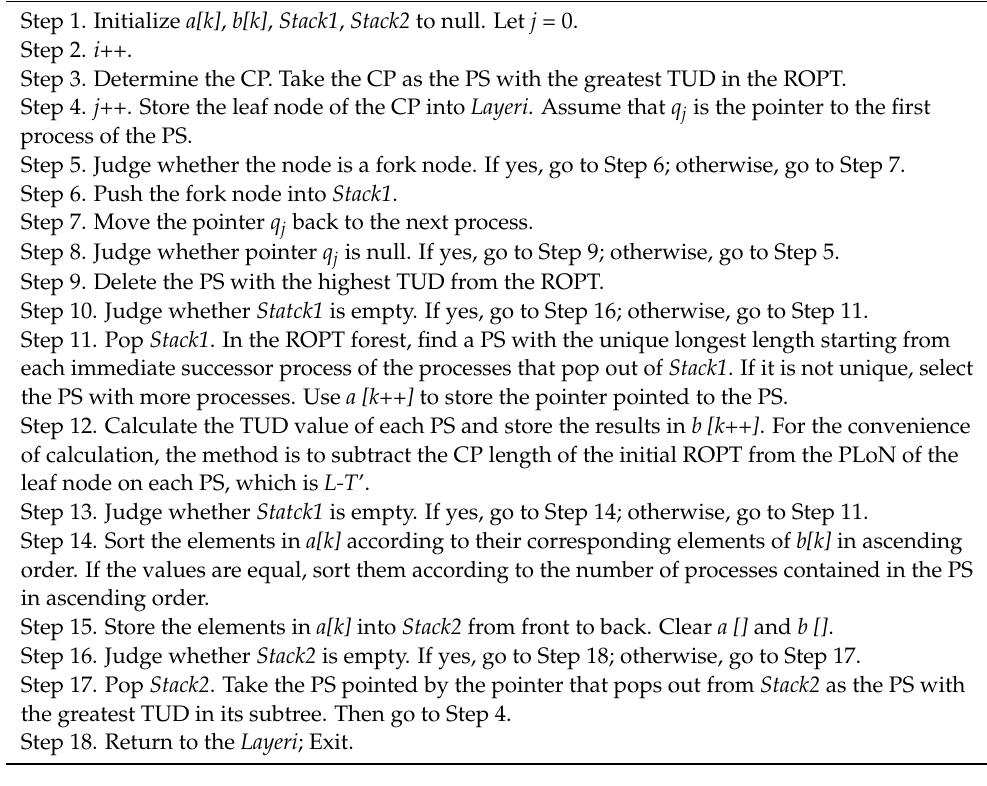
Algorithm 1 The steps of the leaf node sorting algorithm in the current ROPT.